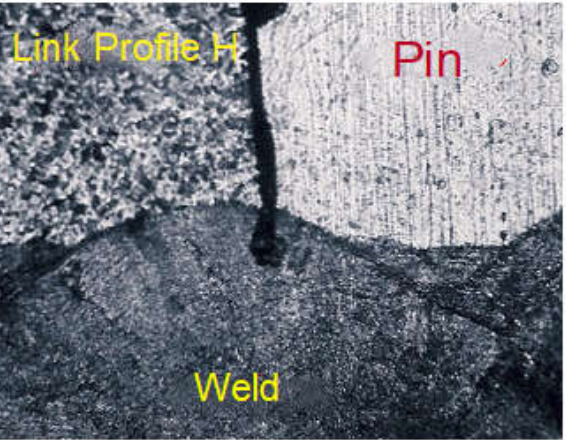
Figure 33. Corrosion at the laser weld/link interface. Optical examination, magnification 5×. Link sample #4 and pin sample #3.